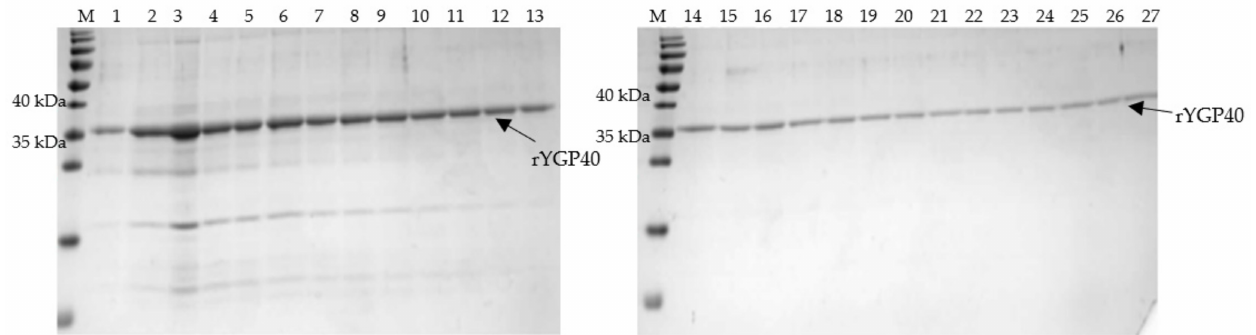
Figure 3. SDS-PAGE analysis of fractions eluted from Talon resin after incubation with solubilized IBs of rYGP40; M— molecular marker: PageRuler Prestained Protein Ladder; lanes 1–27: elution fractions (20 µ L of each 0.5 mL fraction were loaded on